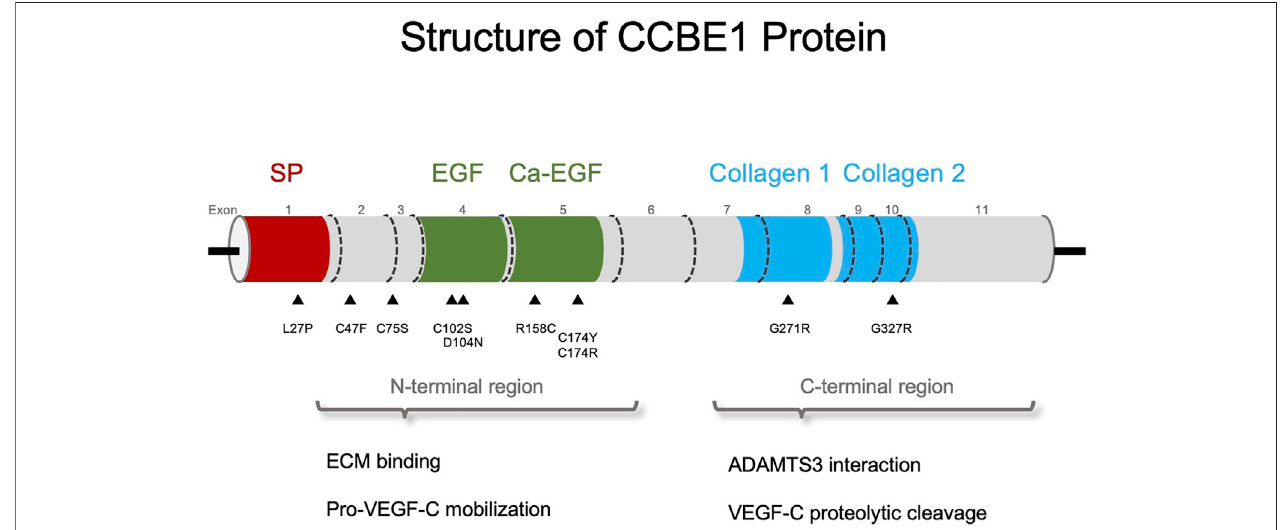
FIGURE 1 | Schematic representation of CCBE1 domains: signal peptide (SP) in red, EGF and calcium-binding EGF (Ca-EGF) domains in green, and collagen repeats (Collagen 1, Collagen 2) in cyan. The triangles indicate the CCBE1 mutations screened in Hennekam syndrome patients. The N-terminal region is described to bind to theECM and importantforthe mobilizationof pro-VEGF-C. The C-terminalregion ofCCBE1 interacts with ADAMTS3 promotingthe proteolytic cleavage ofpro- VEGF-C.